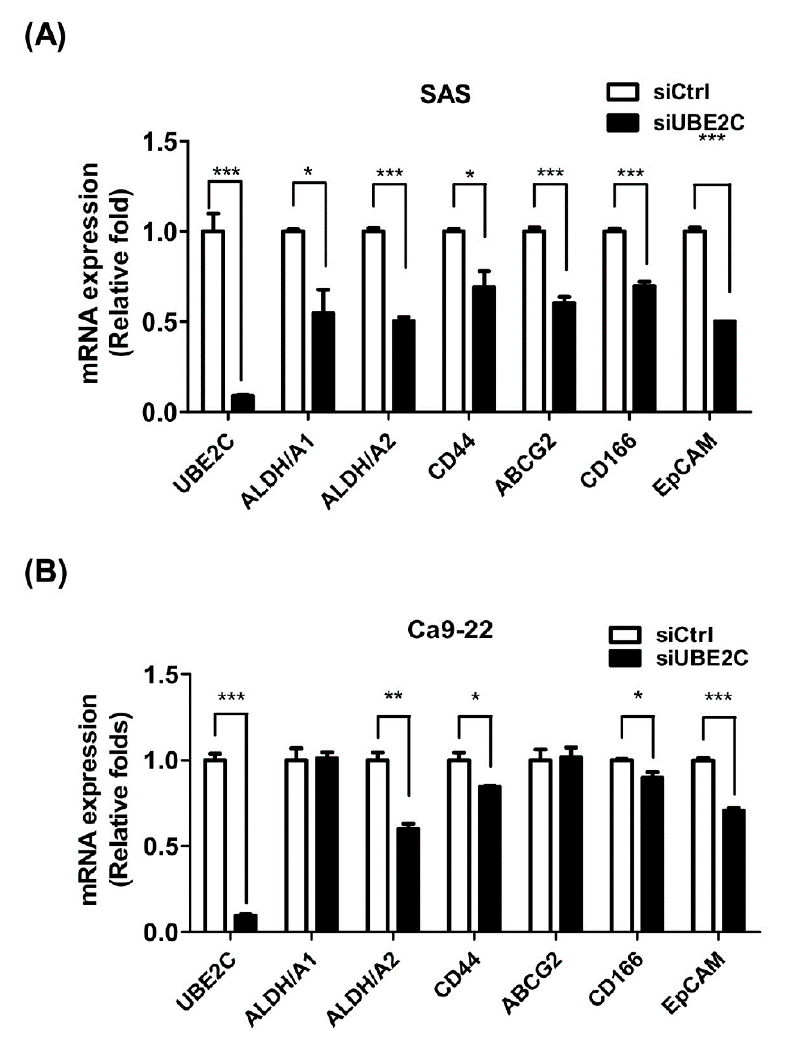
Figure 4. Expression of cancer stemness markers in UBE2C-knockdown OSCC cells. ( A ) SAS cells. ( B ) Ca9-22 cells. The expression levels of the ALDH1 / A1, ALDH1 / A2, CD44, ABCG2, CD166 and EpCAM in cells transfected with scrambled s siRNA (5 nM, siCtrl) or siRNAs against UBE2C (5 nM, siUBE2C) were detected by real time polymerase chain reaction (RT-PCR) and GAPDH was used as an internal control. The quantitative results are expressed as the mean ± SD from three independent experiments. * p < 0.05, ** p < 0.01 and *** p < 0.001 vs. nontargeting control siRNA (siCtrl).